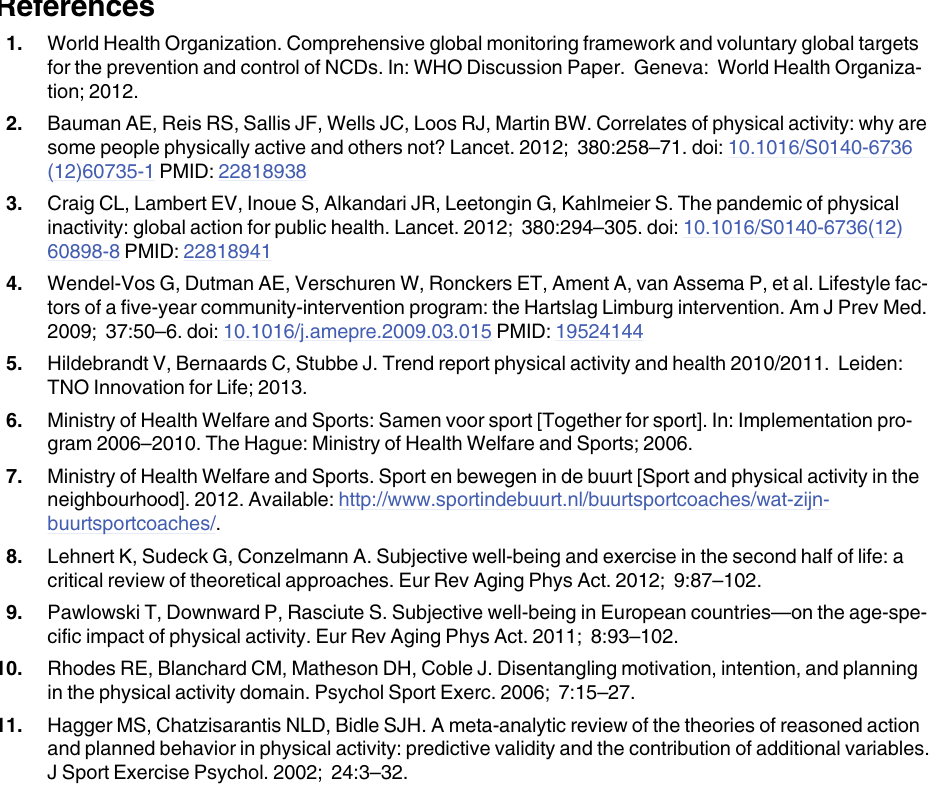
S1 Table. Overview of variables measured over time in relation to PA